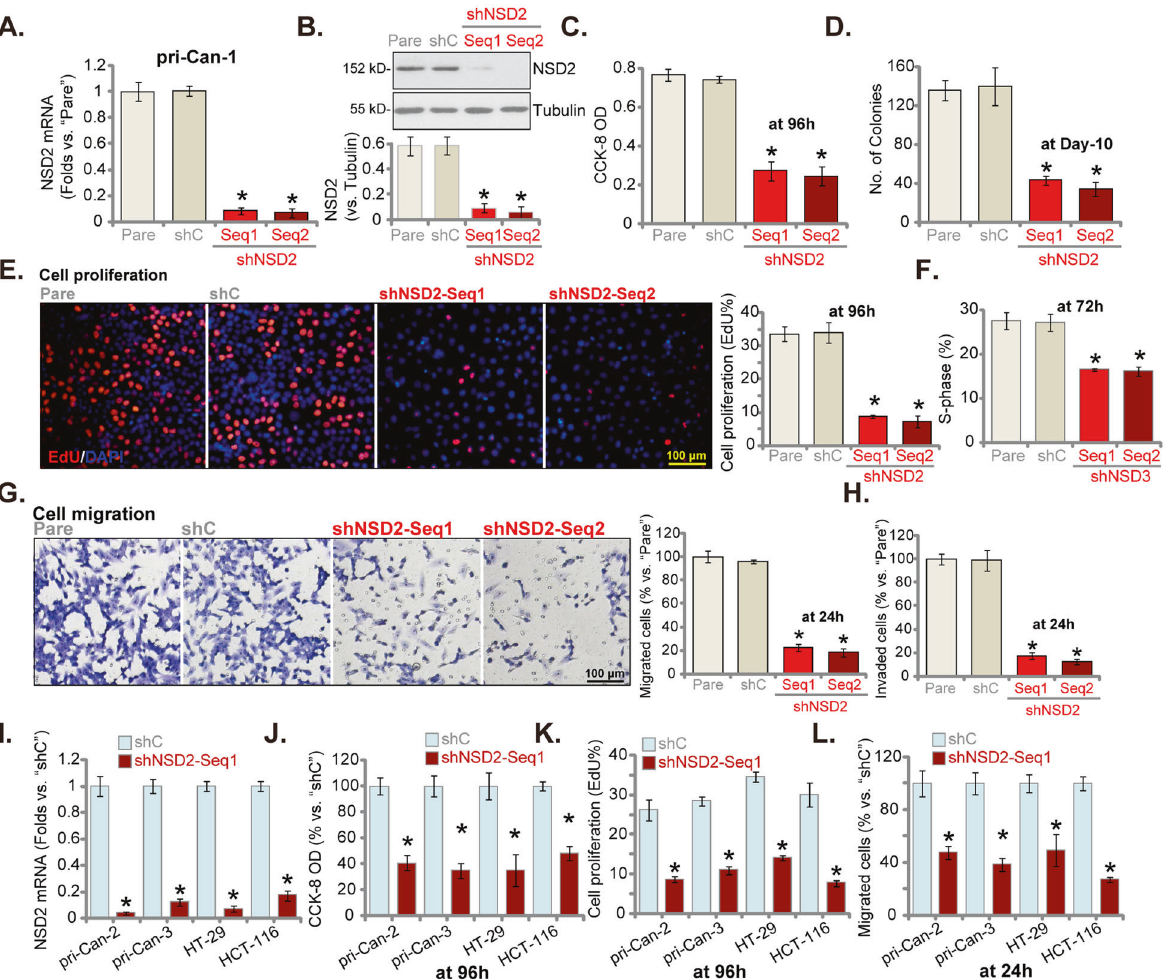
Fig. 2 NSD2 shRNA produces signi fi cant anti-cancer activity in CRC cells. The primary human colon cancer cells ( “ pri-Can-1/-2/-3 ” , A – L ) or established CRC cell lines (HT-29 and HCT-116, I – L ) were transduced with applied lentiviral NSD2 shRNA ( “ shNSD2-Seq1/2 ” ) or scramble non- sense control shRNA ( “ shC ” ), stable cells were established following selection by puromycin. Expression of NSD2 mRNA ( A and I ) and listed proteins ( B ) were shown. Cells were further cultured for applied time periods, cell viability was tested by CCK-8 ( C , J ) and colony formation ( D